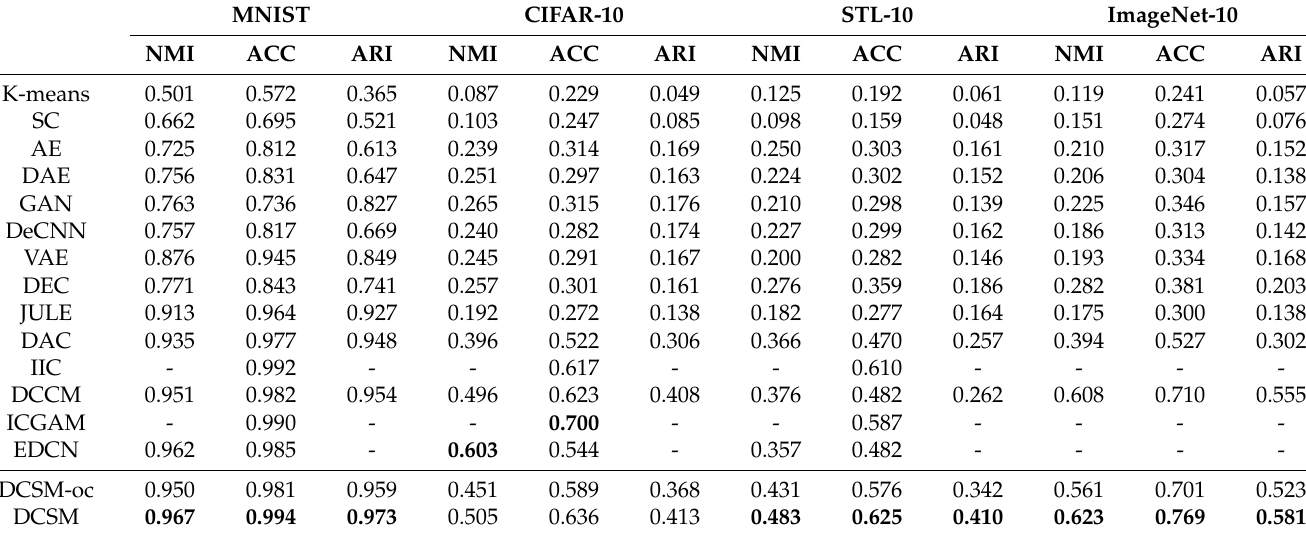
Table 3. Clustering performance of different methods on four datasets. The best results are high- lighted in